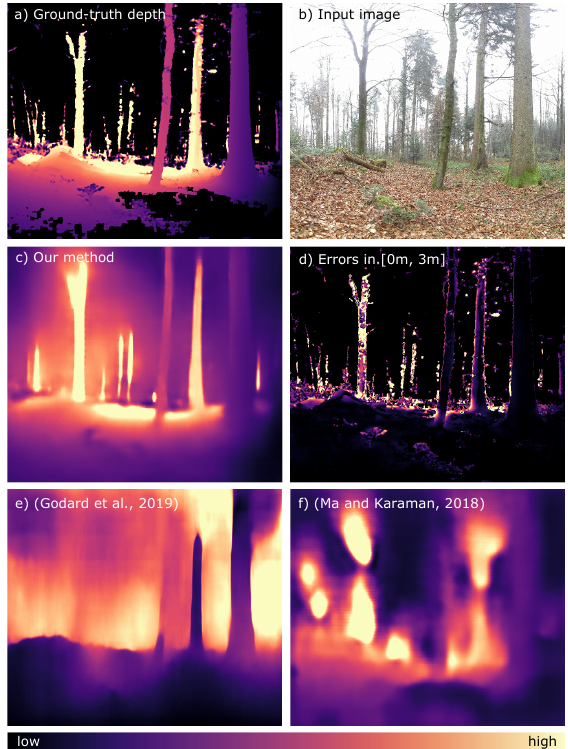
Figure 1. Depth prediction based on monocular forest images: a) and b) are input and ground truth; c), e) and f) are depth predictions with different methods; d) is absolute error between depth predicted with our model and the ground